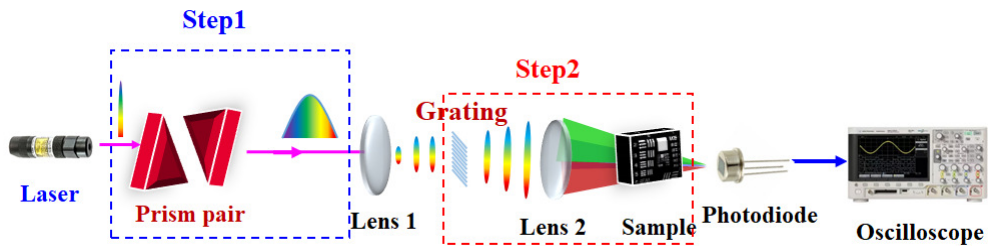
Figure 10. Schematic arrangement of PTS imaging with prism pair: Step 1, wavelength-to-time mapping; and step 2, frequency-to-space mapping. The prism pair is composed of Ge material.